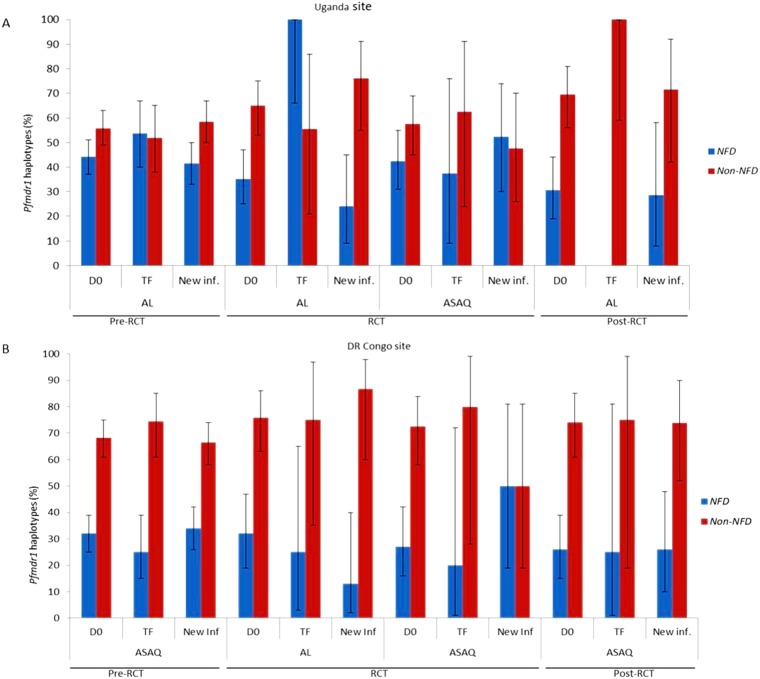
Comparison of the distribution of Pfmdr1 NFD and non-NFD haplotypes (95% Confidence intervals) by site in pre- and post-treatment outcomes in AL and ASAQ treatment arms.Haplotypes present amino acid residues at codon N86Y, Y184F, D1246Y (N = Asparagine, Y = Tyrosine, F = Phenylalanine, D = Aspartic acid, K = Lysine, T = Threonine). D0 = Day 0, TF = PCR-corrected treatment failure, ACPR = Adequate clinical and parasitological response.